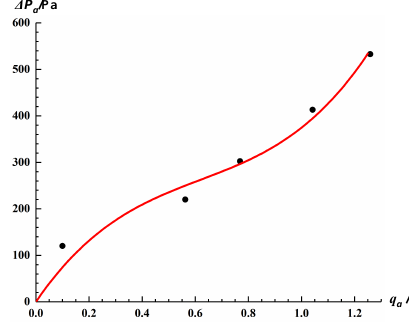
Figure 5. ∆ P a of the cooling system.